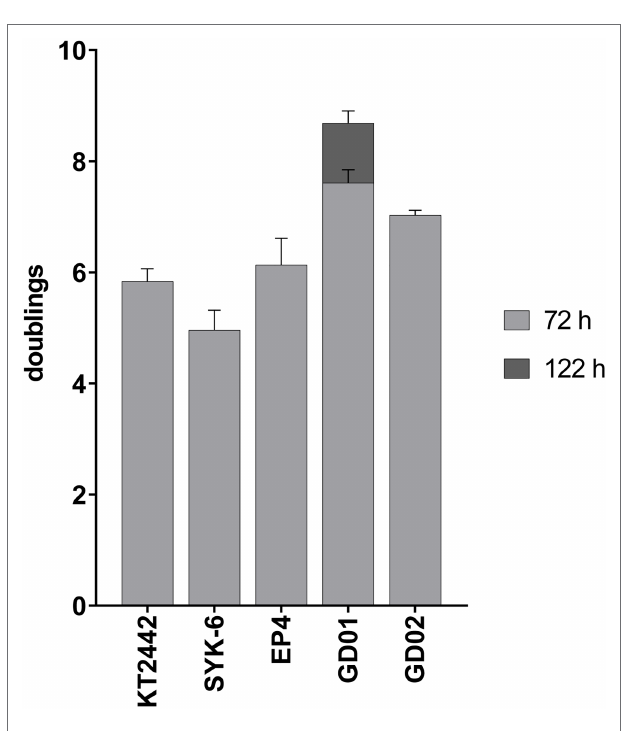
growth on LB was not inhibited by any of the four extracts.